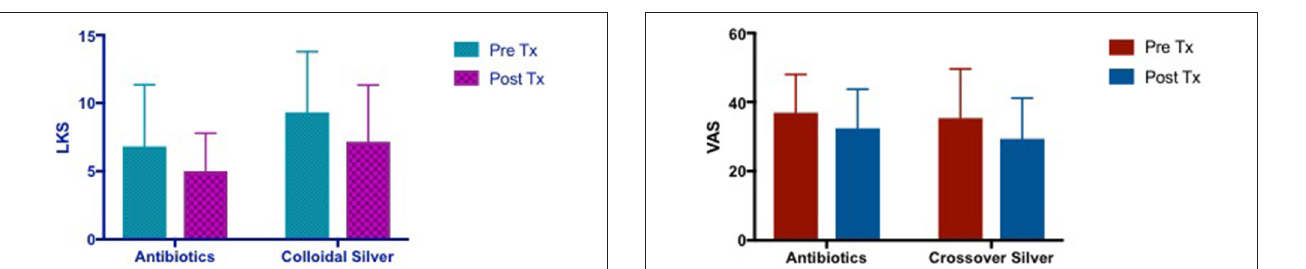
FIGURE 4 | Bar graph showing similar improvements in LKS in both CON and CS groups, but not statistically significant. LKS, Lund Kennedy Scores; CON, Control; CS, Colloidal silver.